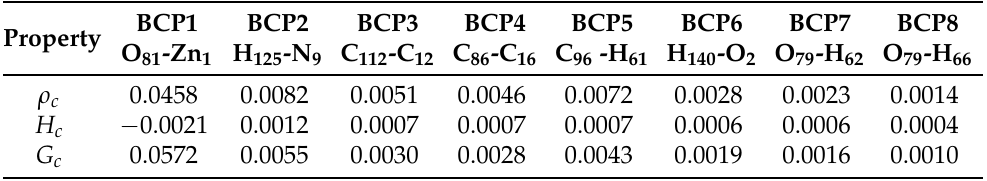
Table 3. QTAIM properties of Zn-zdimer at bond critical points (BCPs) (in a.u.). Property